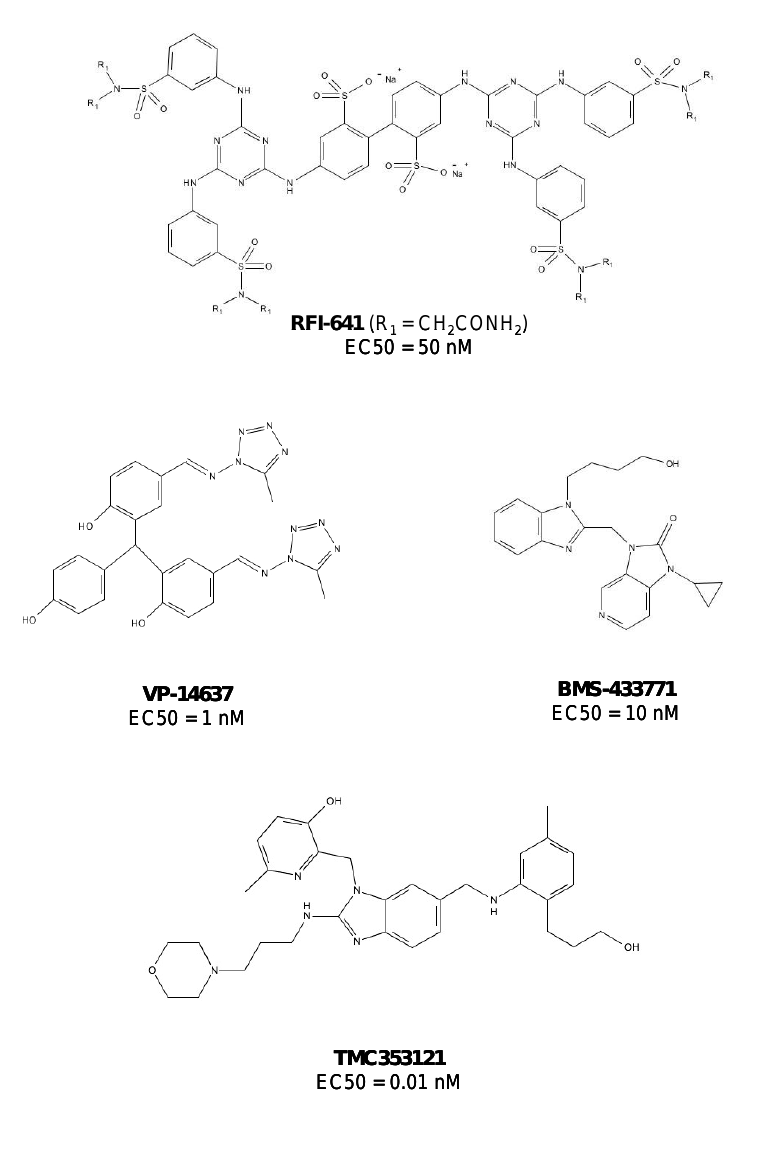
Figure 3. Chemical structures of small-molecule RSV entry inhibitors targeting F